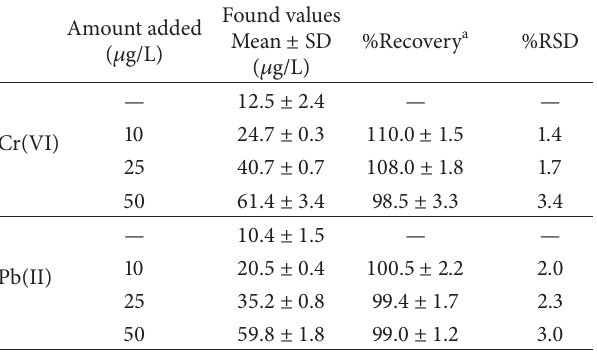
Table 2: The results for tests of addition/recovery for Cr(VI) by DLLME in industrial wastewater samples ( 𝑛 = 6